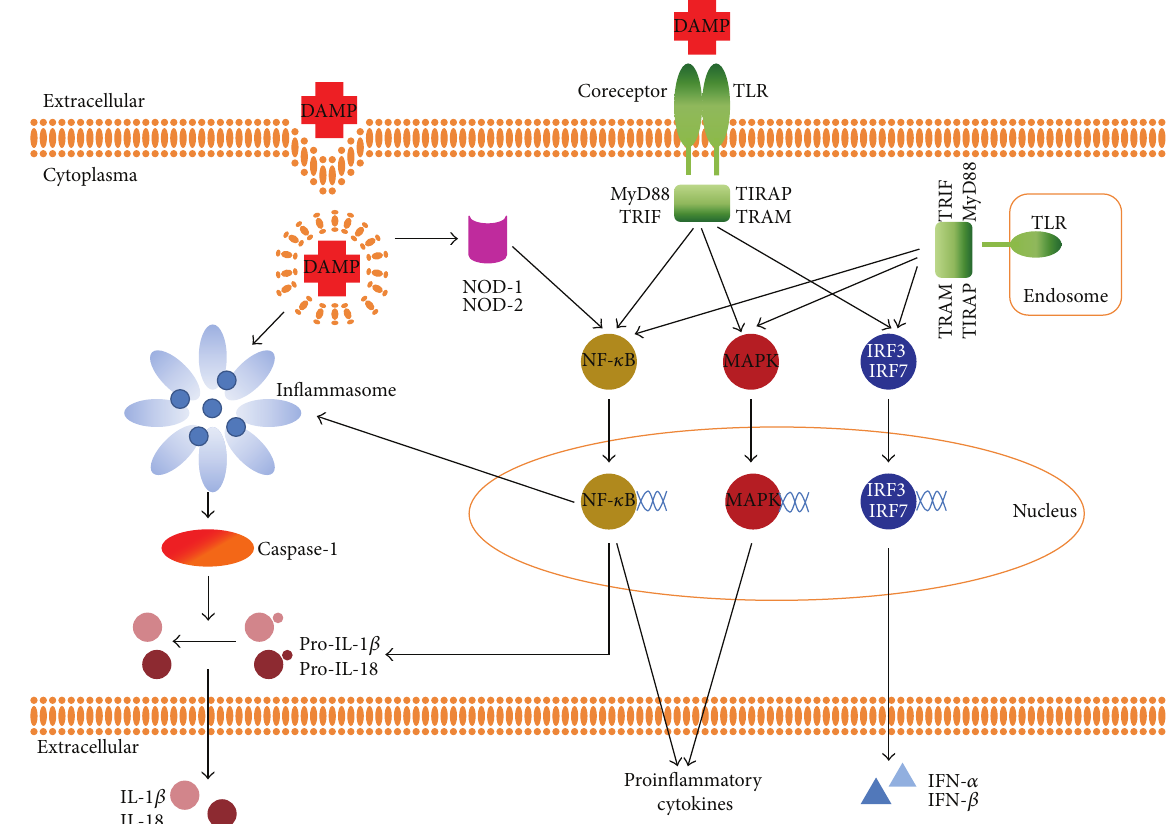
Figure 1: DAMP signaling through different PRRs. TLR activation by DAMPS triggers adaptor proteins MyD88, TRIF, TIRAP, or TRAM to activate various transcriptions factors. The subsequent translocation of NF- 𝜅 B and MAPK leads to the production of several proinflammatory cytokines. TRIF-dependent activation of transcription factors IRF3 and IRF7 results in the induction of type I interferon. Additionally, the TLR- NF- 𝜅 B pathway can induce the transcription of pro-IL-1 𝛽 , pro-IL-18, and other components of the inflammasome